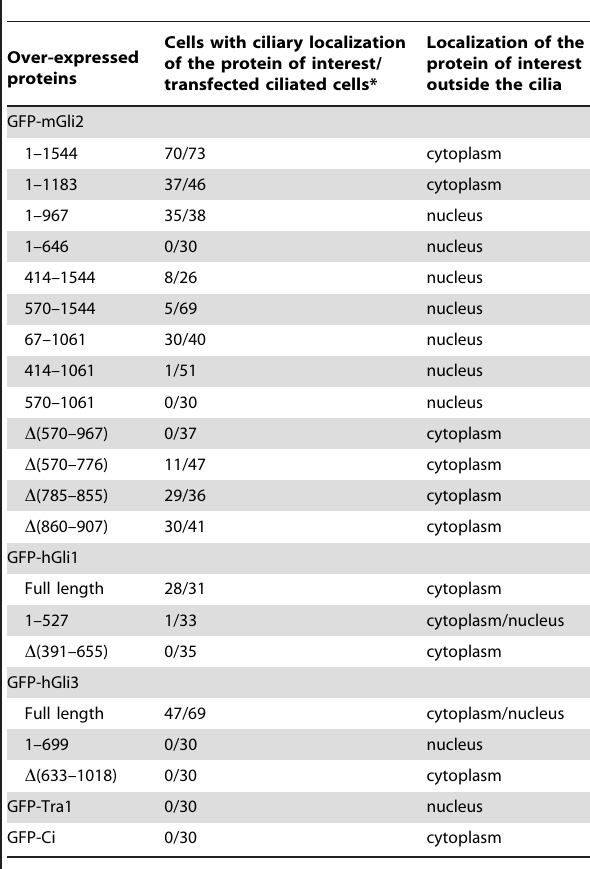
Table 1. The subcellular localization of various Gli proteins over-expressed in mouse ciliated